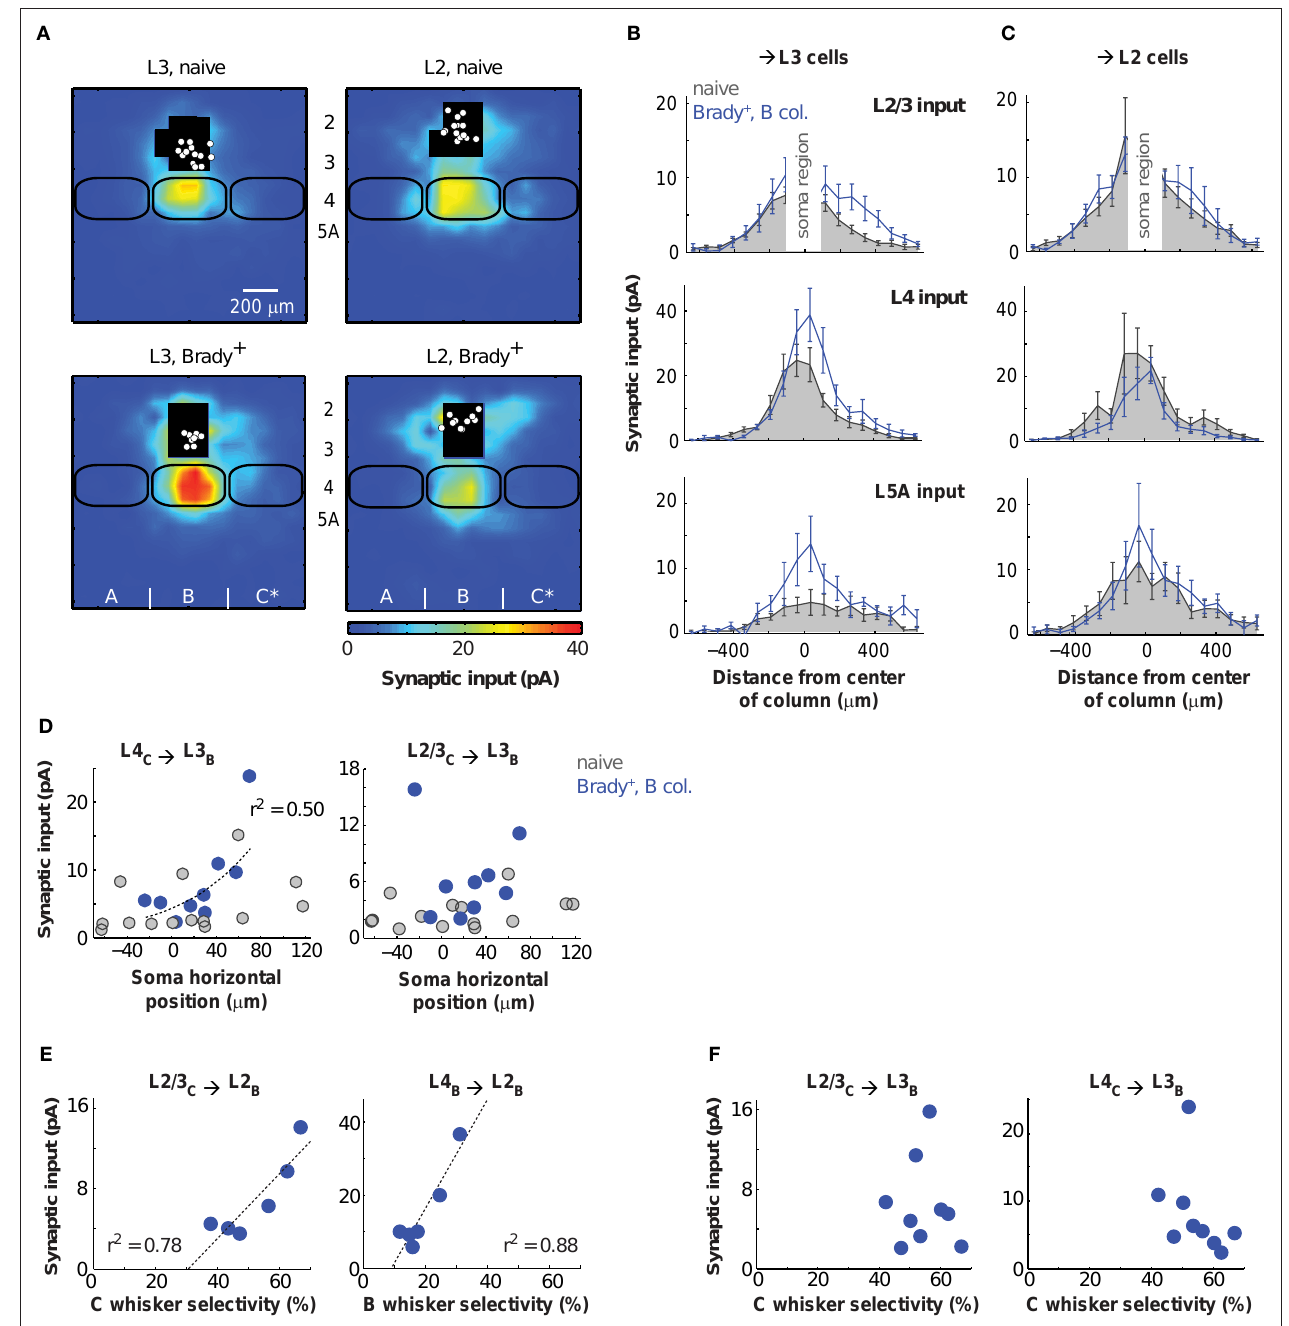
Figure 3 | Distinct plasticity in layer 2 and layer 3. (A) Synaptic input maps of L3 (left) and L2 (right) cells recorded in naive (top) and Brady + (bottom) mice. (B) Horizontal profiles of synaptic inputs for L3 cells. The analyzed regions of inputs are as in Figure 2g . (C) Same as in B for L2 cells. (D) Strength of transcolumnar L4 and L2/3 projections as a function of soma → L3 → L3 C B C B horizontal position. Zero on the x -axis is the center of the B column. (e) Strength